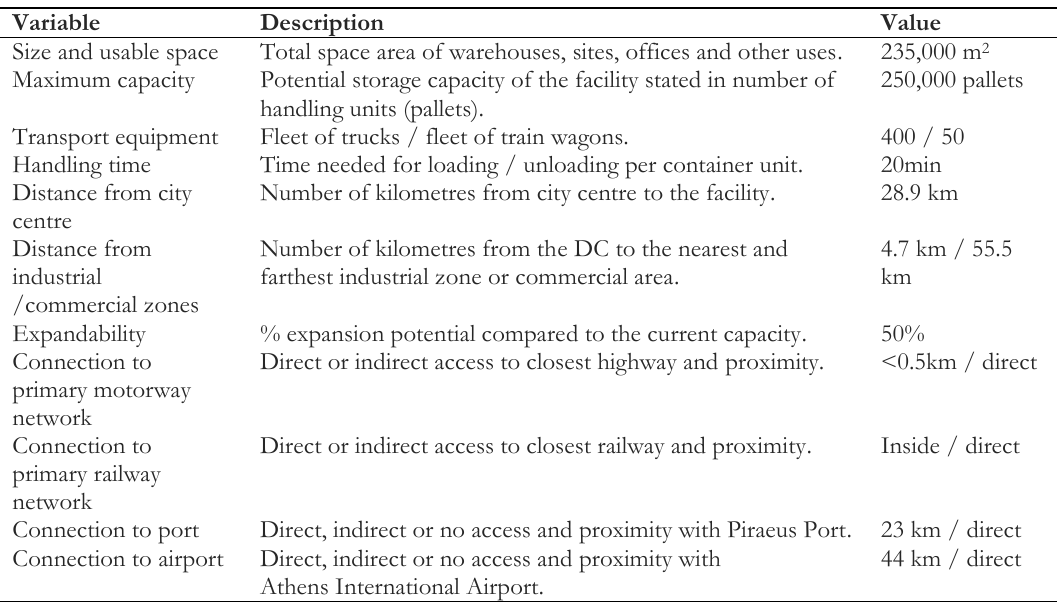
Table 1. Characteristics of thriasio logistics